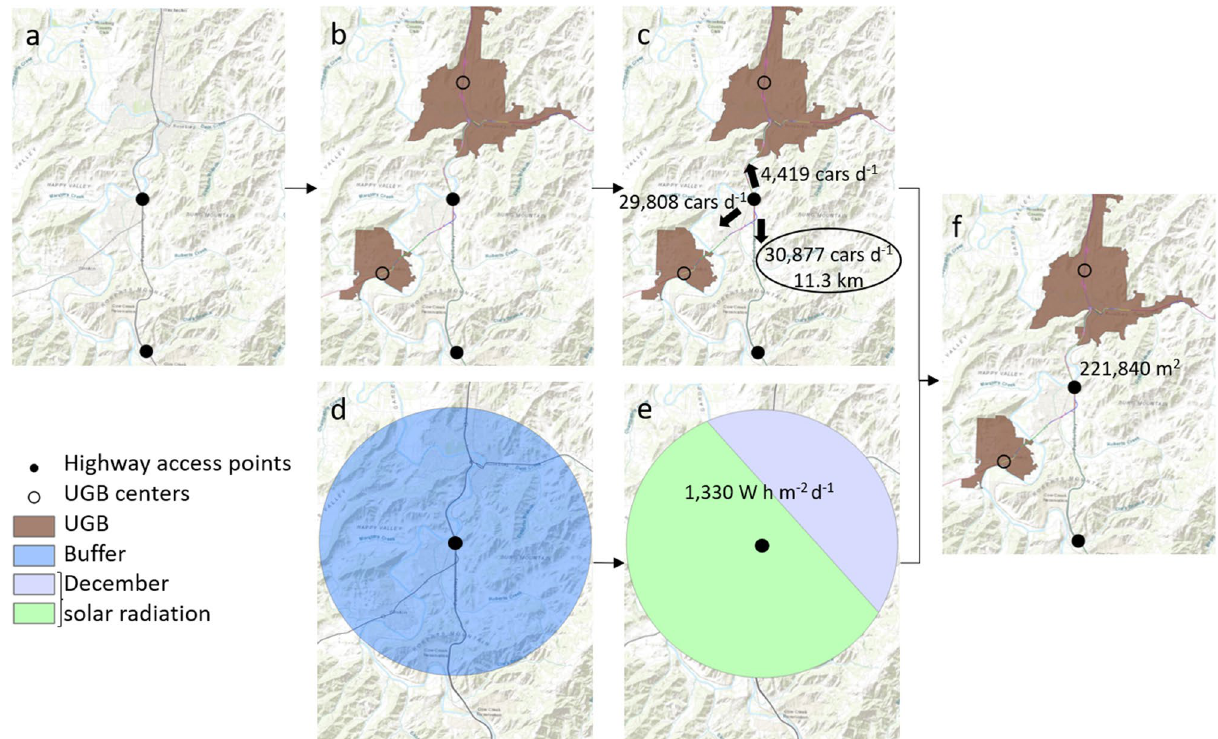
Figure 4. Analytical steps in creating demand layer. ( a ) highway access points, ( b ) centroid of urban growth boundaries (UGB) snapped to highway and color-coded, 20-year average annual daily traffic (AADT), ( c ) weighted average AADT in all possible routes from a highway access point with the maximum value and corresponding distance selected, ( d ) 8.8 km (5.5 mi) buffer around highway access points, ( e ) clipped solaration raster and corresponding weighted average of December solar radiation, ( f ) final demand in areal